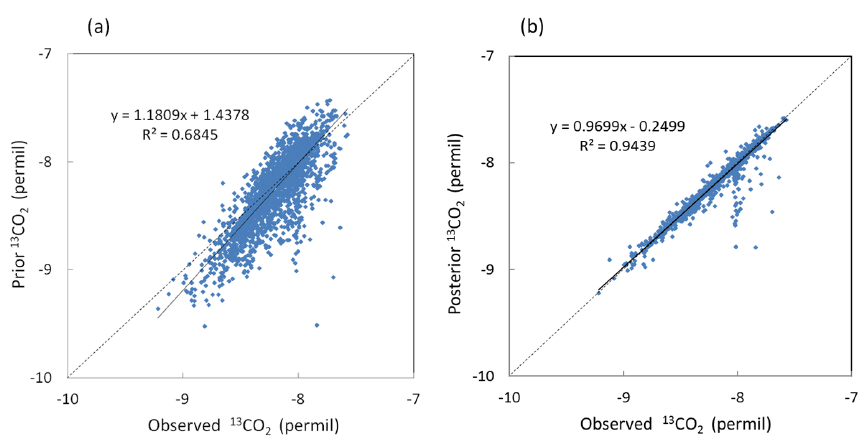
Figure 15. Comparison of prior (a) and posterior (b) 13 CO 2 compositions with observations. The prior composition is obtained through transport modelling with prior 13 CO 2 fluxes from the terrestrial ecosystems, oceans, fossil-fuel emission and biomass burning, and the posterior composition is obtained with the CO 2 – 13 CO 2 joint inversion (case